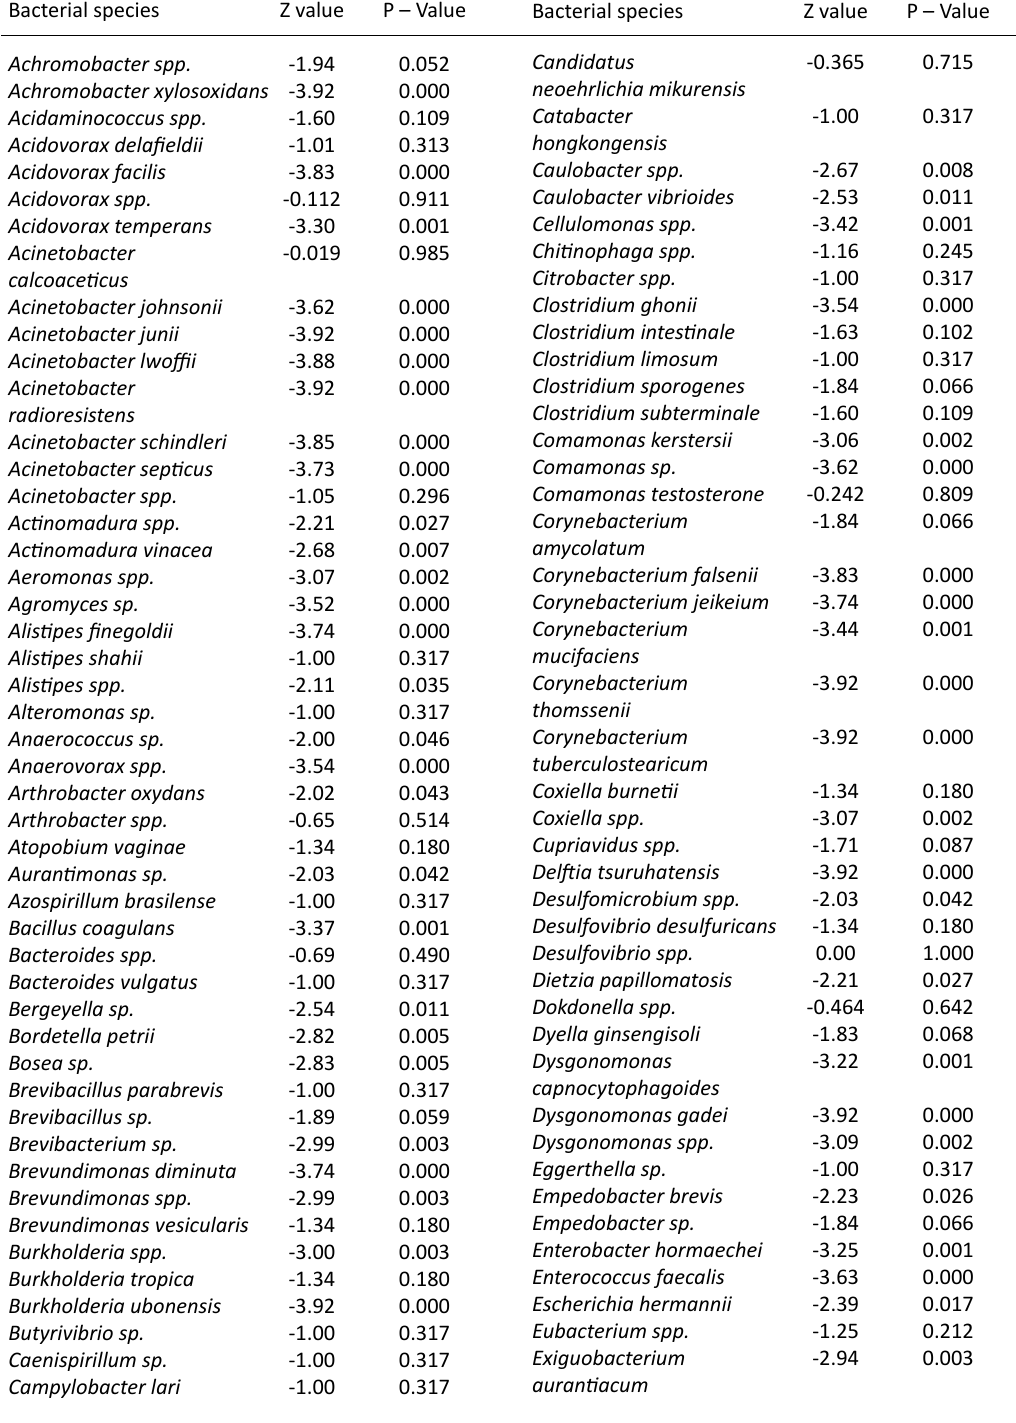
table 1. Wilcoxon rank test performed to determine the influence of season on the abundance of the detected human bacterial pathogens Bacterial species Z value P – Value Achromobacter